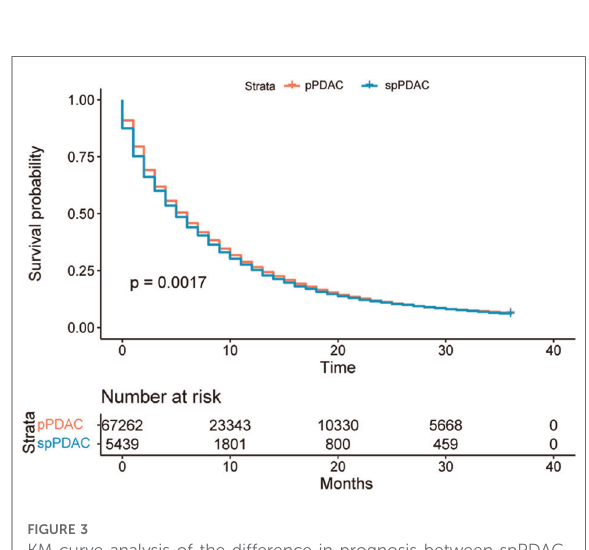
FIGURE 3 KM curve analysis of the difference in prognosis between spPDAC and pPDAC